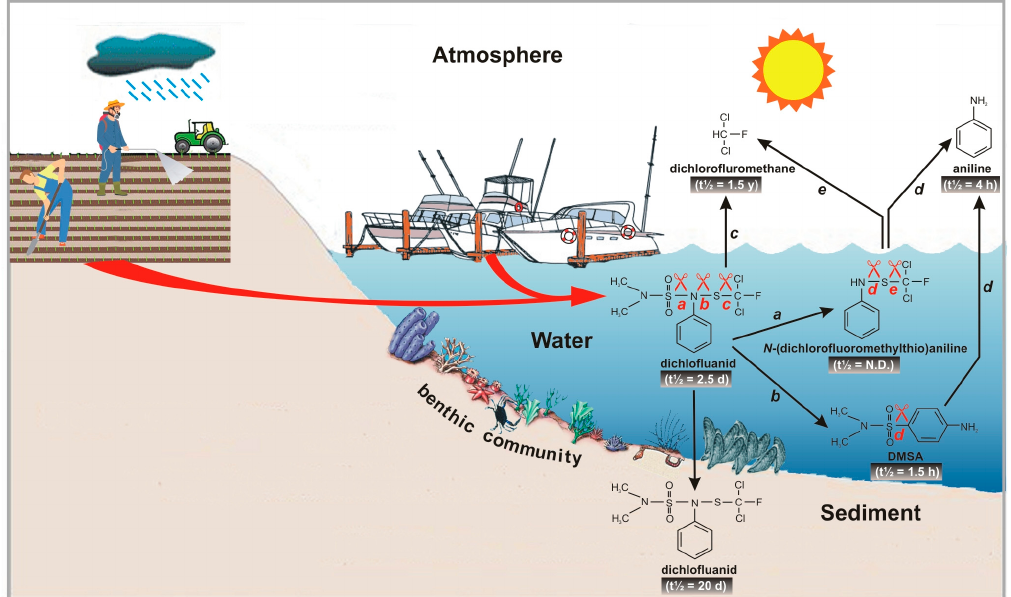
Figure 1. The main sources of environmental pollution of dichlofluanid (in agriculture as a fungicide and from boats as an antifoulant) and the biogeochemical fate of dichlofluanid and its derivatives. Black arrows show the degradation pathways by photodegradation, hydrolysis and biotic and abiotic anaerobic processes in seawater, sediments and air. Half-times are indicated below each product (N.D.—not determined). Bond cleavages are represented by shears and letters. Note the rearrangement of the N - N- dimethyl sulphonyl group in the para position after bond cleavage from dichlofluanid to DMSA.